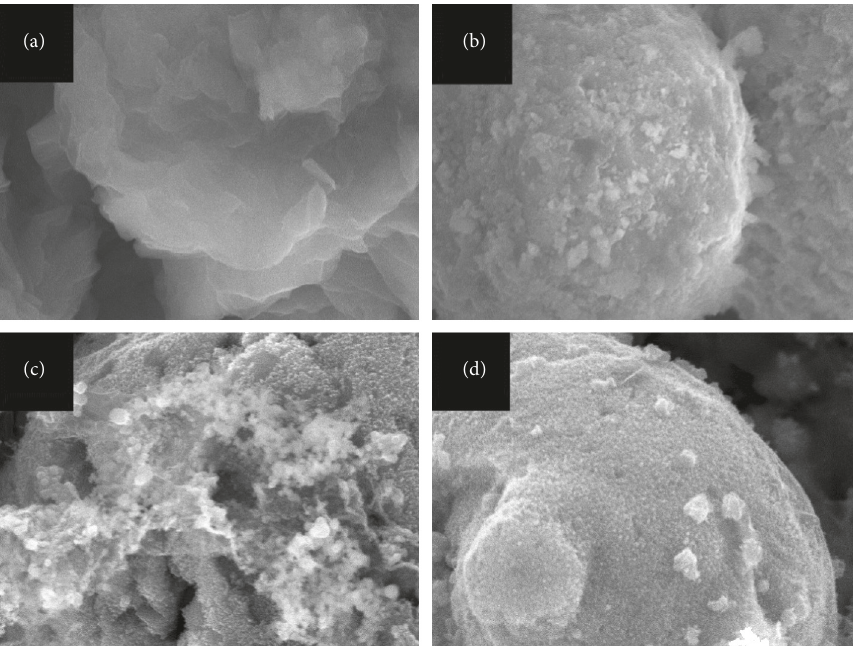
Figure 2: Scanning electron microscopy images of the surfaces of (a) graphene oxide (sample GO), (b) zinc metal, (c), sample ZG2, and (d) sample ZG5. The scale bars under each of the letters for (a) and (b) are 2 micrometers, while for (c) and (d) are 1 micrometer, in